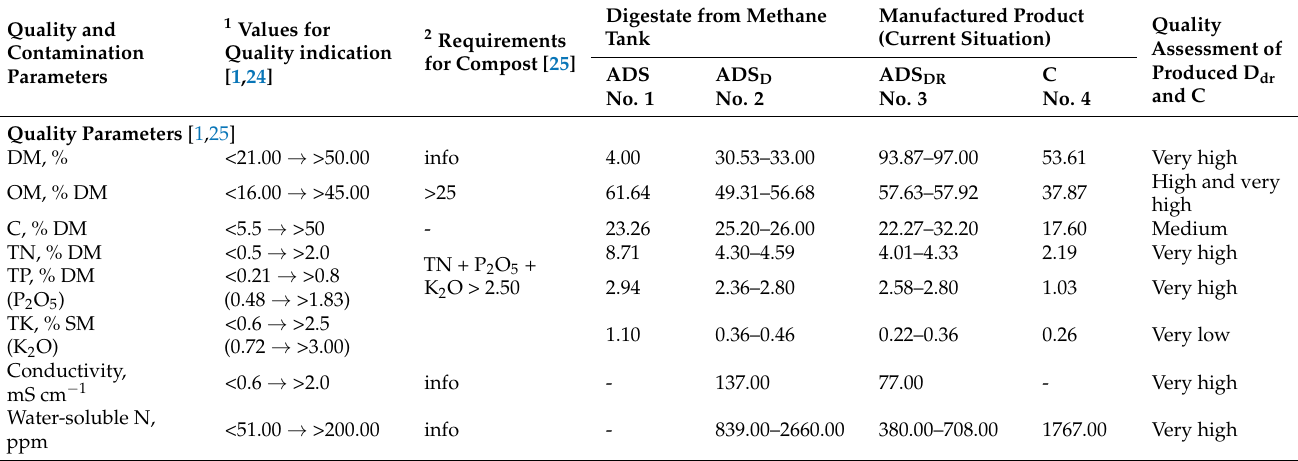
Table 2. The results of laboratory analyzes of anaerobically digested sludge (ADS no1), dewatered anaerobically digested sludge (ADS D no. 2), dried anaerobically digested sludge (ADS DR no. 3), and compost (C no.